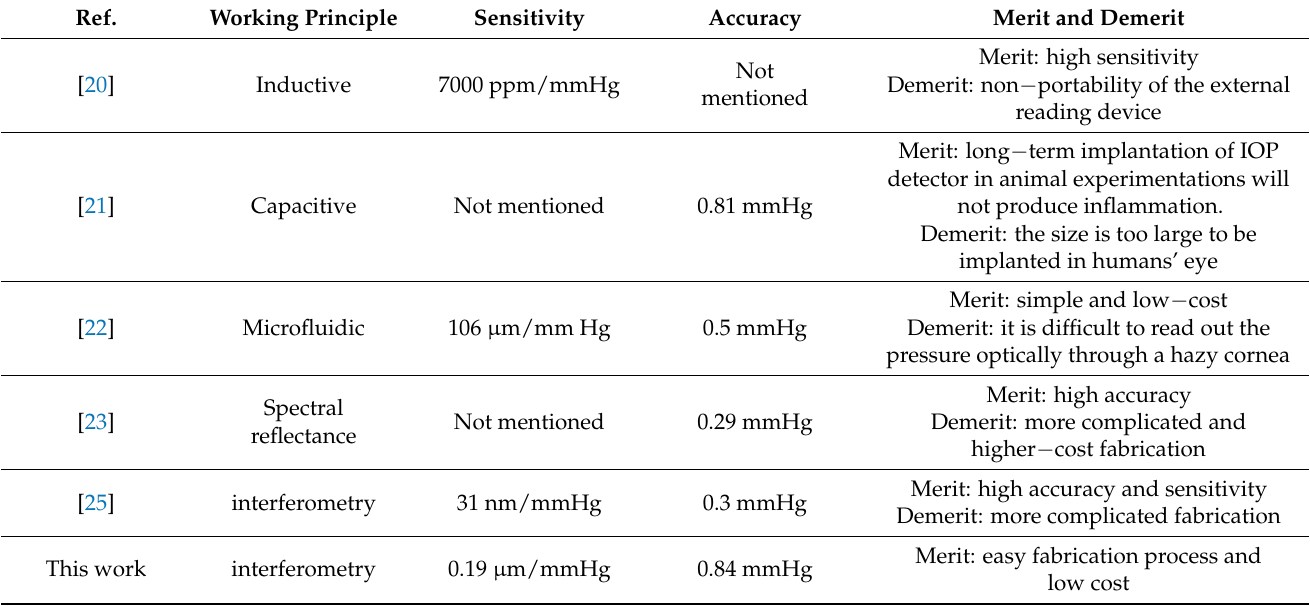
Table 2. Comparison of our implantable IOP sensor with previous